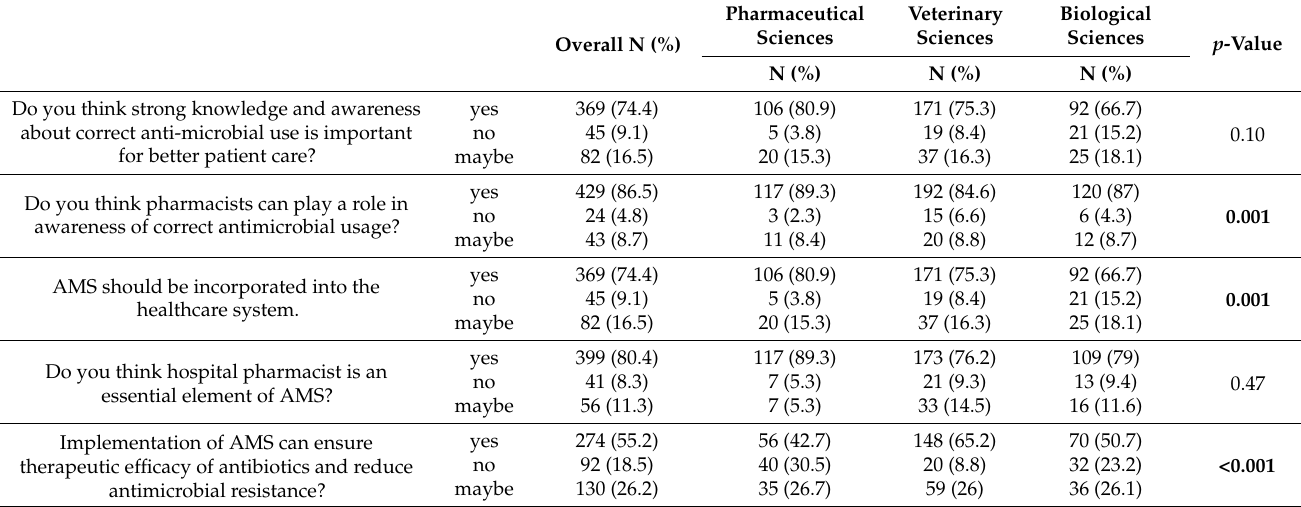
Table 5. Participant’s perception of antimicrobial stewardship (AMS).